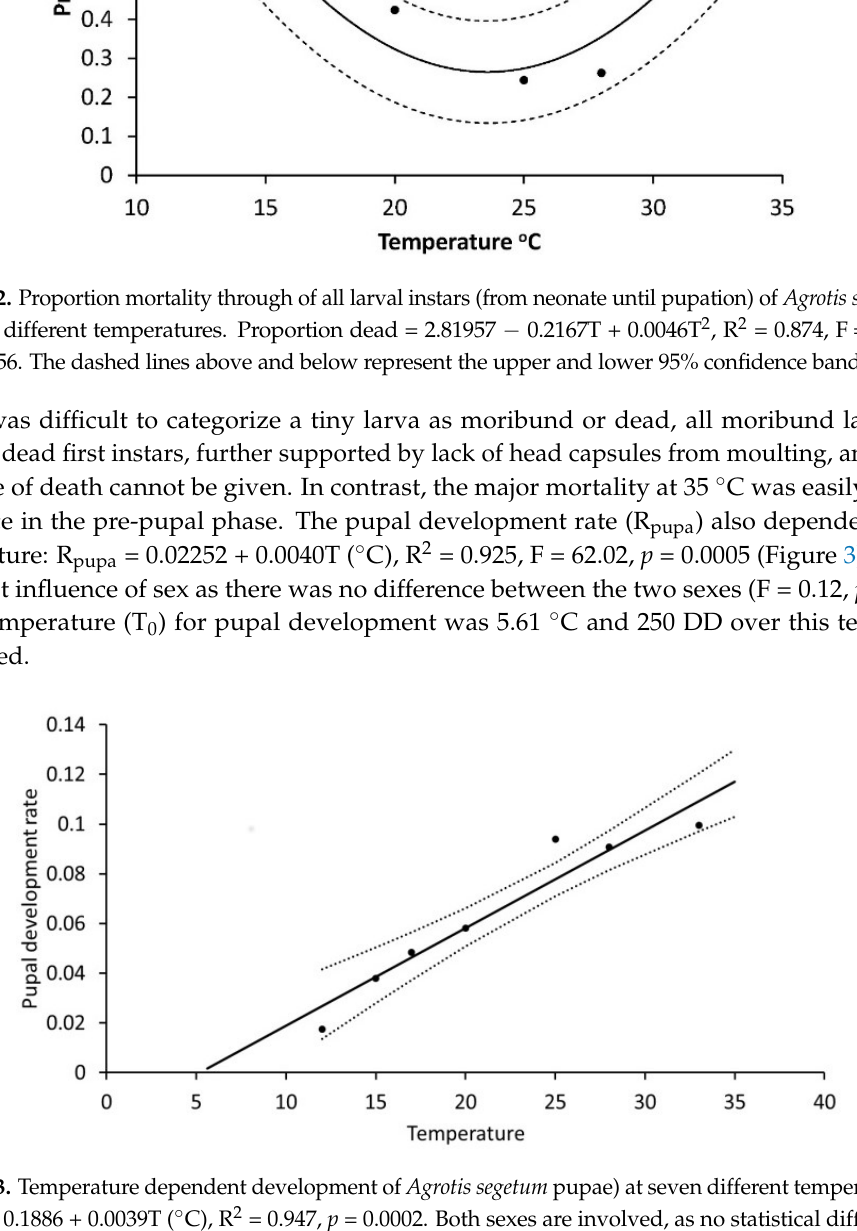
Figure 3. Temperature dependent development of Agrotis segetum pupae) at seven different temperatures; R pupa = 0.1886 + 0.0039T (°C), R 2 = 0.947, p = 0.0002. Both sexes are involved, as no statistical difference was found between the two sexes. The dashed lines above and below represent the upper and lower 95% confidence bands.